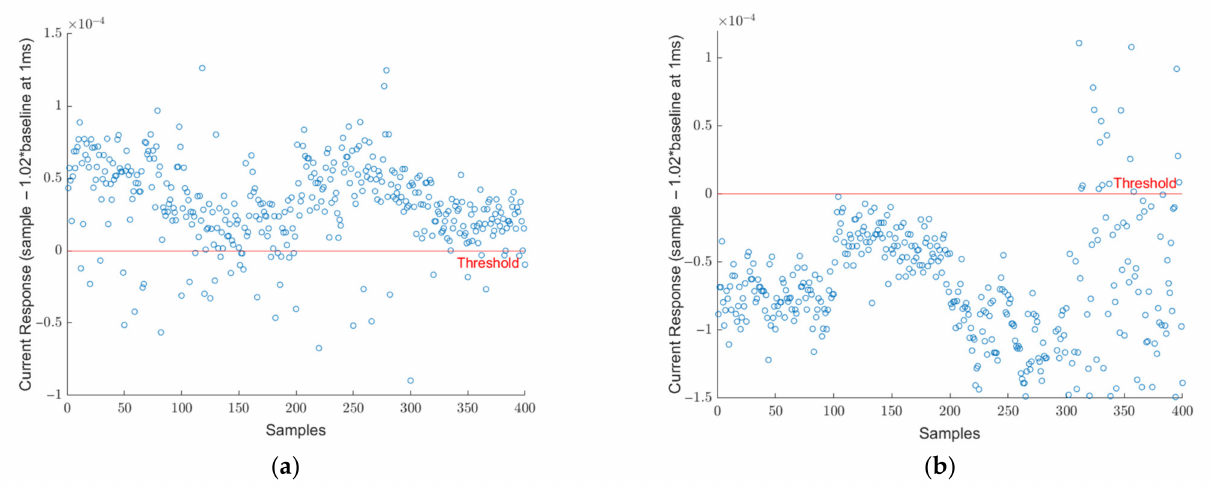
Figure 5. ( a ) Signature analysis of 400 MERS-CoV samples, while 356 samples were above the threshold and classified as SARS-CoV-2, 44 samples were under the threshold. ( b ) Signature analysis of 400 Influenza virus samples, only 14 samples are identified as SARS-CoV-2 positive.